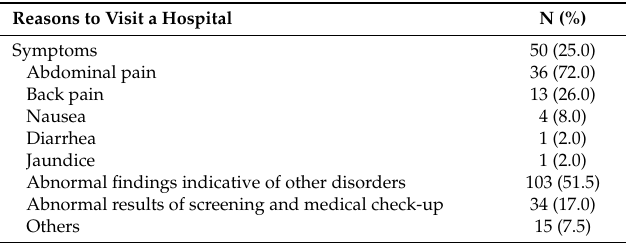
Table 2. Occasion of visiting a hospital in resected pancreatic cancer at an early stage (Stage 0/I =